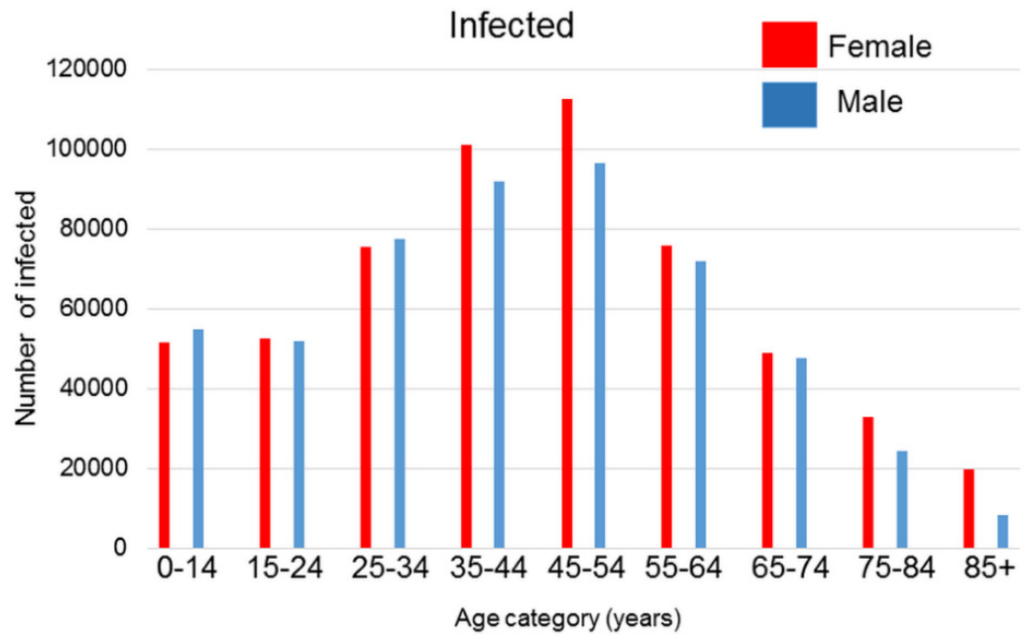
Figure 1. Number of SARS − CoV − 2 infections in the Czech Republic until mid-February 2021 according to the data published by the Ministry of Health of the Czech Republic.